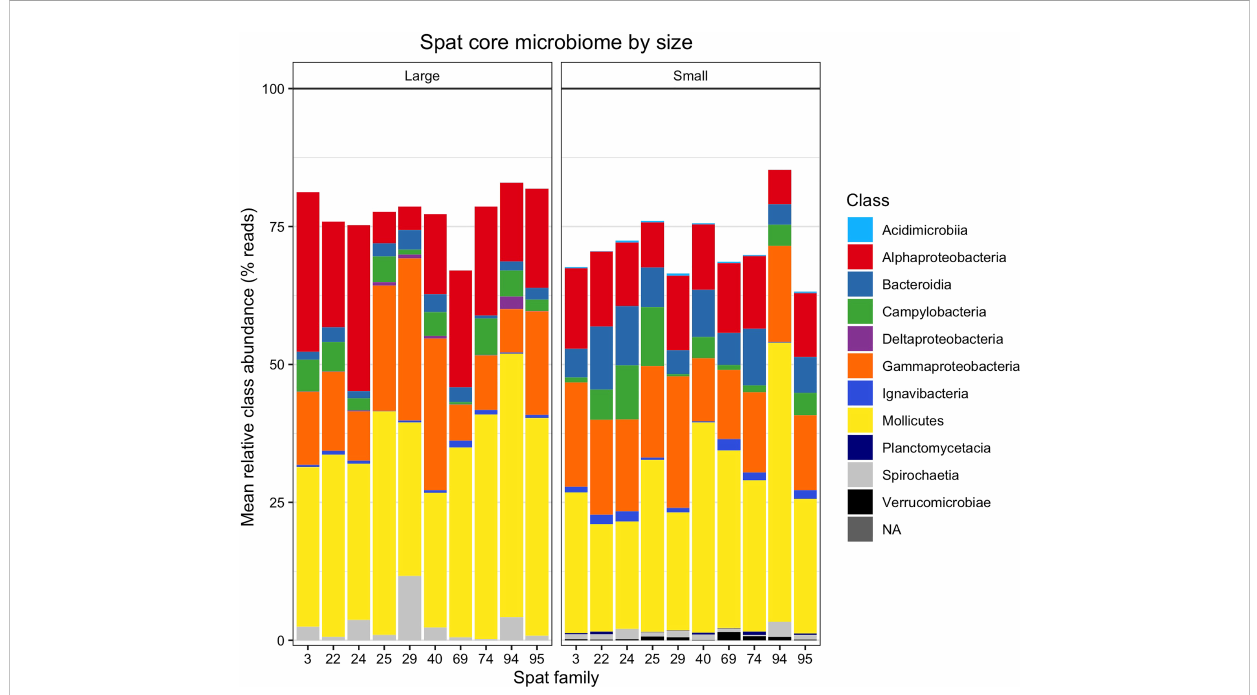
FIGURE 4 Relative abundances of taxonomic classes within the core microbiomes of large and small spat. Relative abundance is averaged by size and oyster family. Each stacked vertical bar represents one oyster family and size class, consisting of 4-8 replicate oysters sampled per family and size class. Abundance does not sum to 100% because non-core microbiome members are